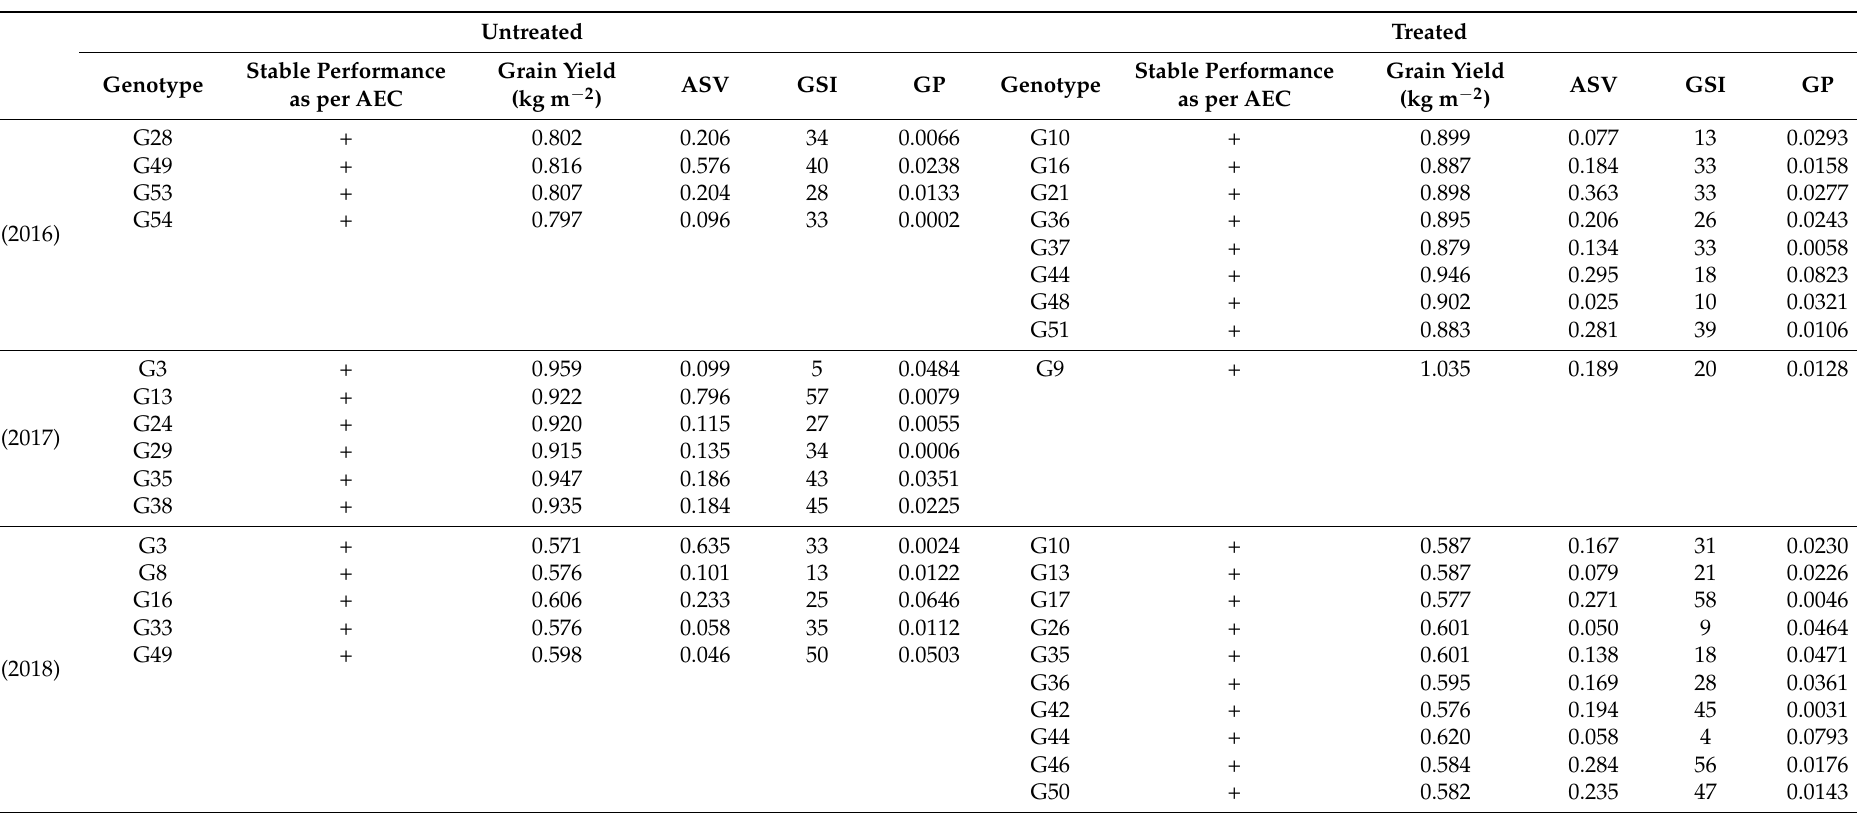
Table 4. Details of the better-performing genotypes with positive genotypic potential (GP), manifesting stable performance for grain yield based on average environmental coordination (AEC), genotype stability index (GSI) and AMMI stability value (ASV) under untreated and treated conditions. (+ sign denotes stable